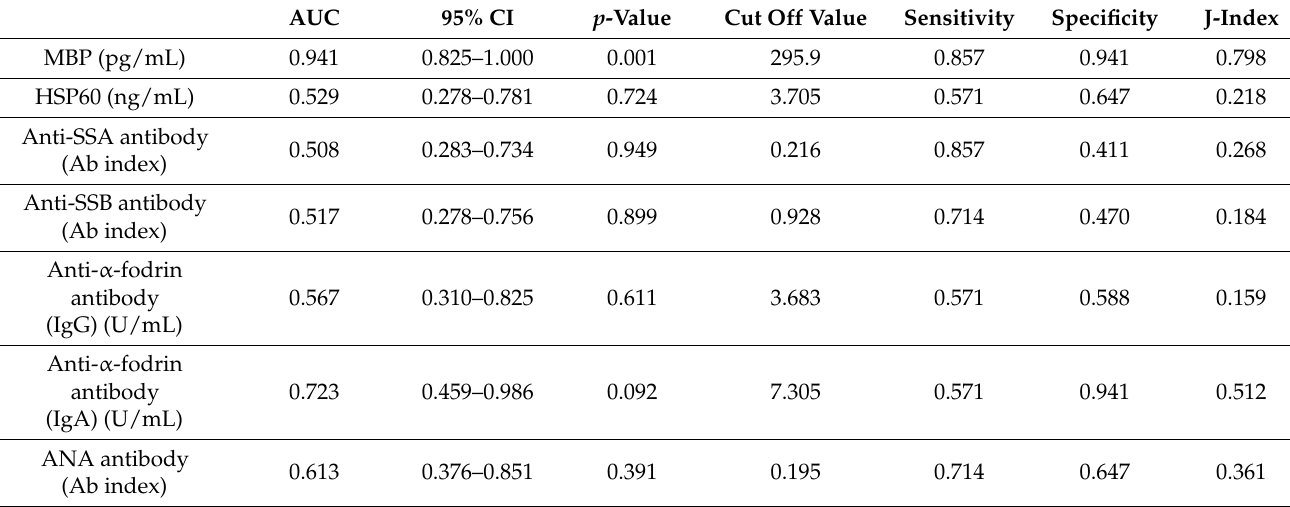
Table 4. Receiver operating characteristics curve analysis for discrimination between control and HTG.